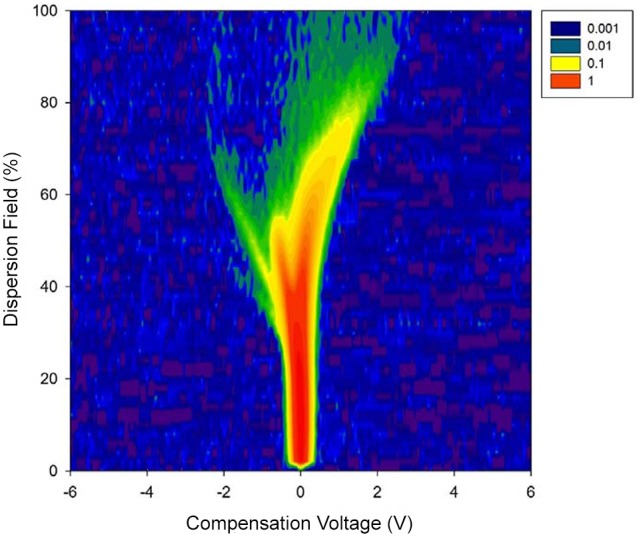
Raw FAIMS output for a Coeliac patient urine sample.